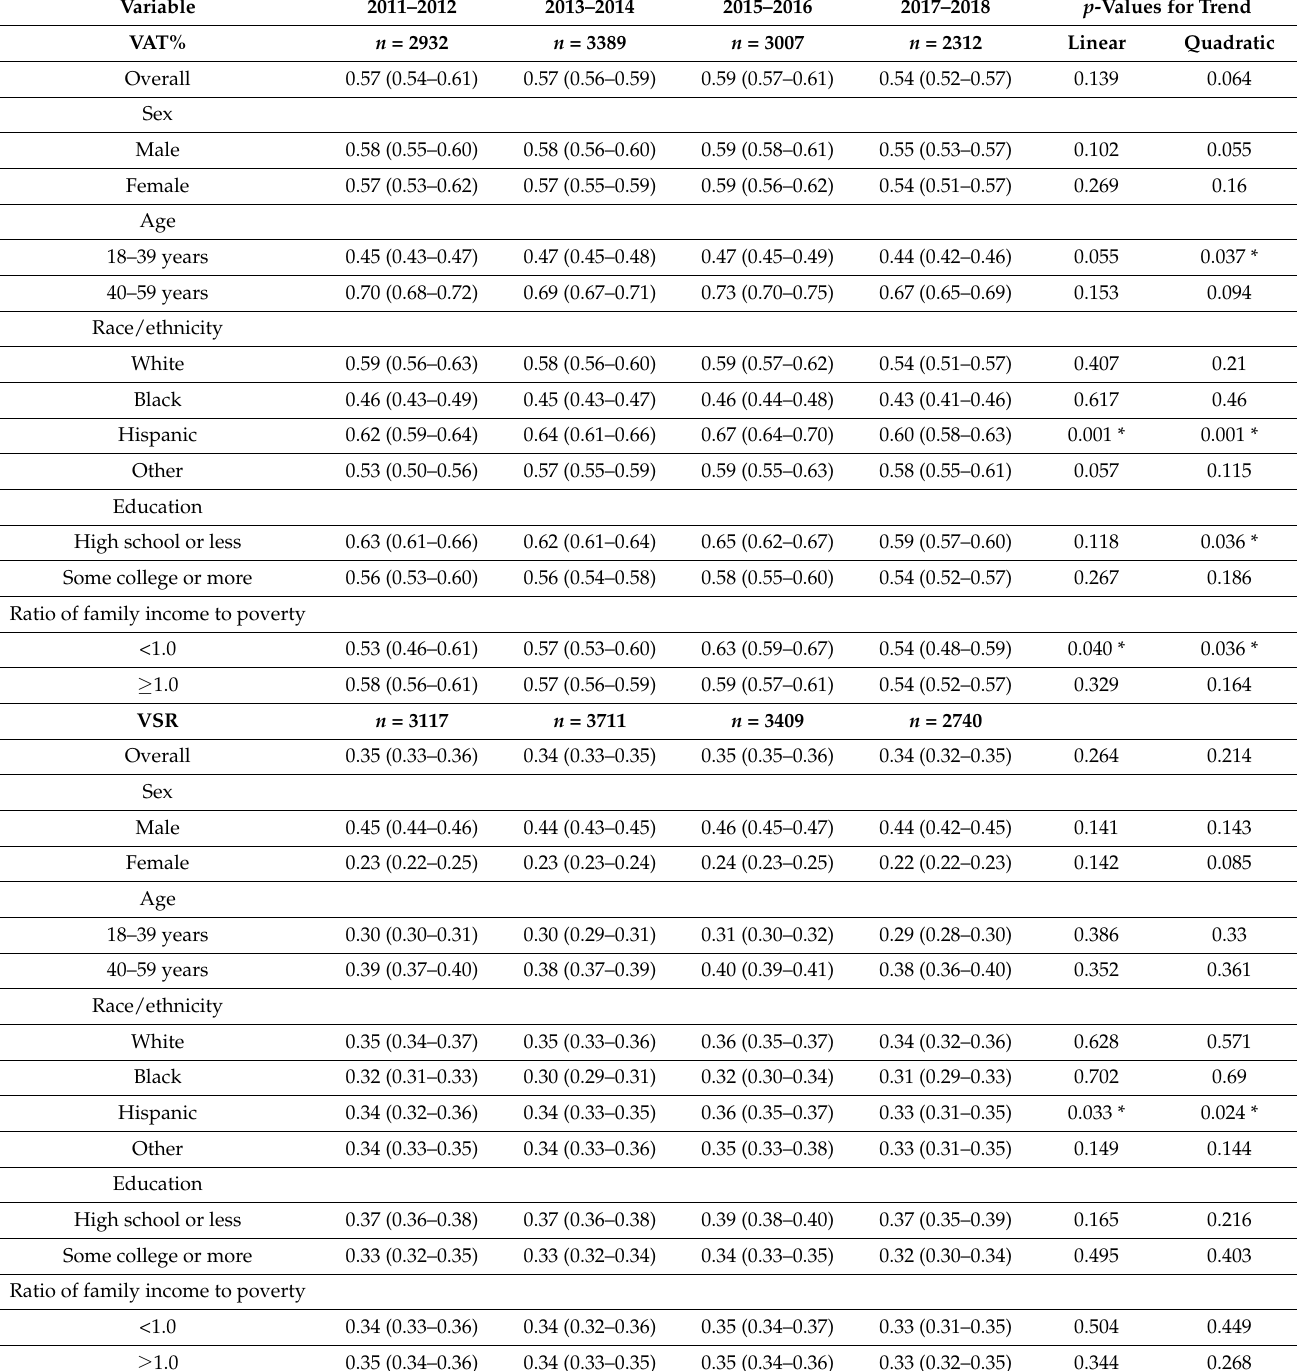
Table 2. The abdominal fat composition and distribution trends, NHANES